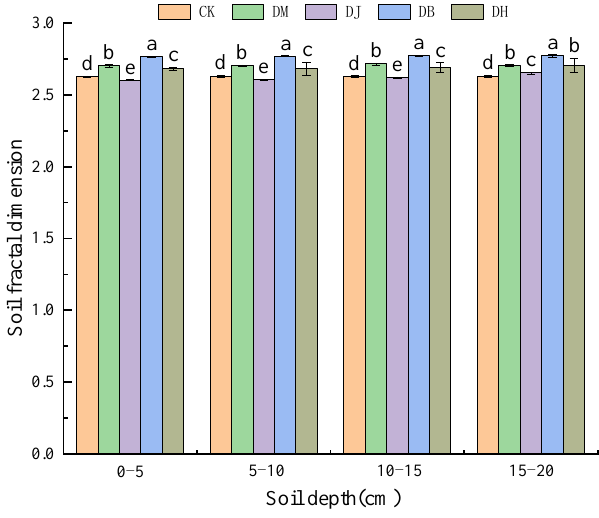
Figure 7. Changes in soil fractal dimension in different treatments.